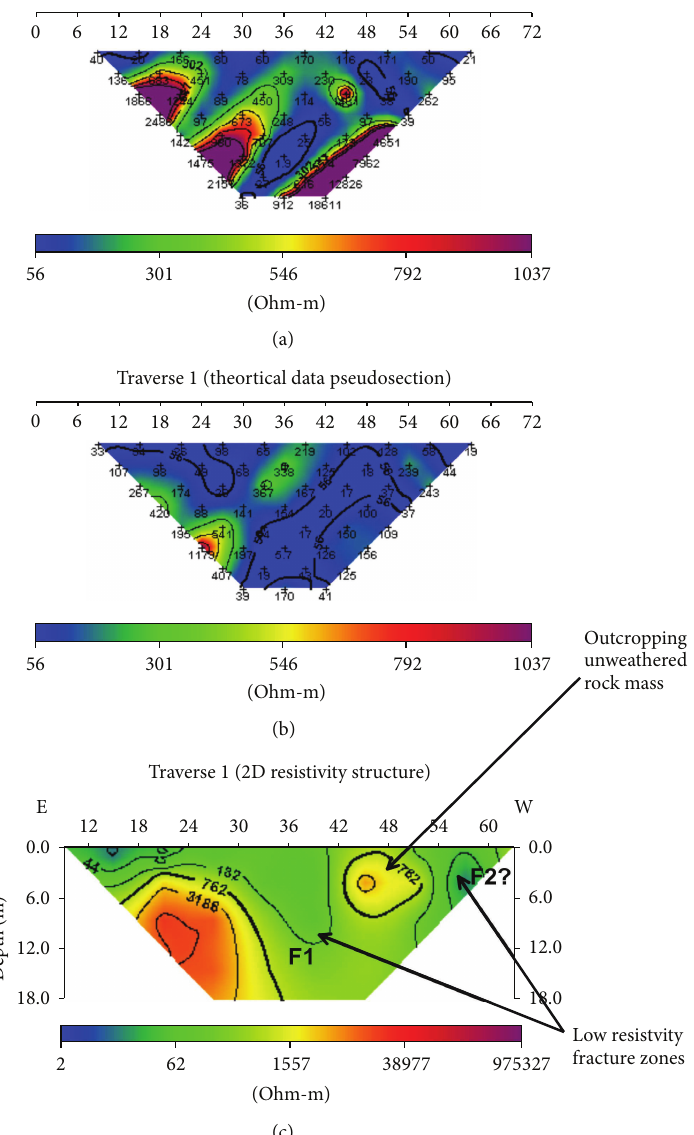
Figure 4: Composite plot of the results of 2D resistivity inversion along TR1: (a) observed resistivity data pseudosection, (b) computed resistivity distribution, and (c) inverted resistivity structure. Low resistivity structures F1 and F2 (interpreted as fracture paths) are separated by a high resistivity structure which outcrops as crystalline rock a little north of the